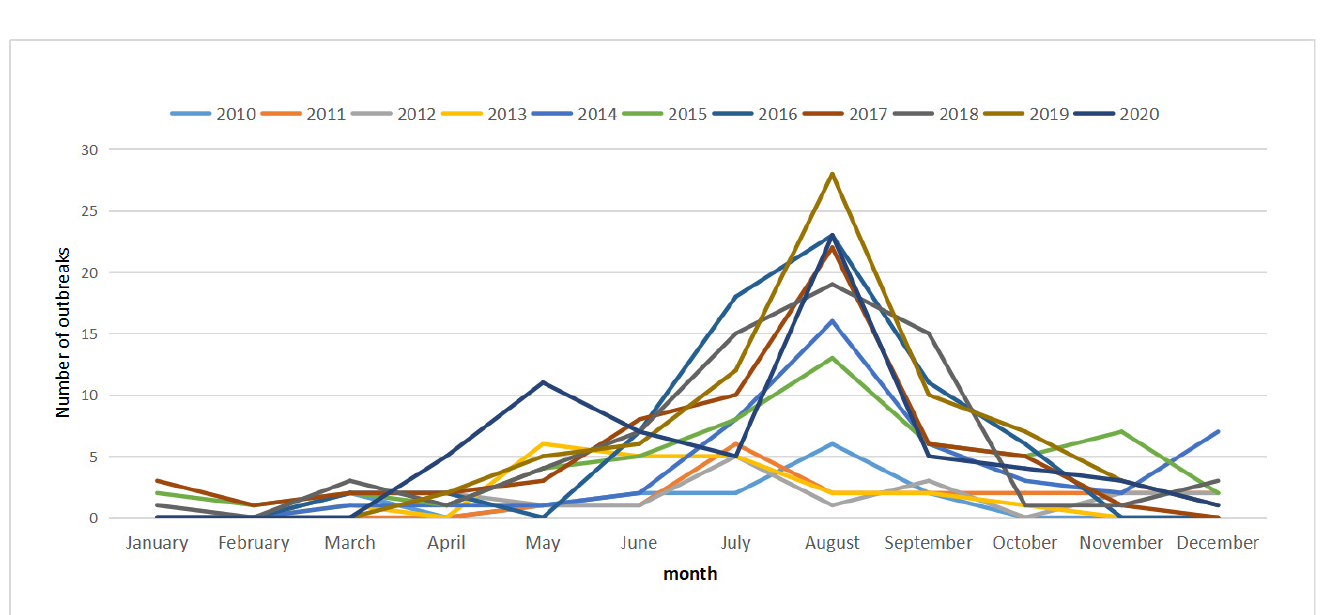
Figure 1. Year-month distribution of outbreaks of bacterial FBDOs in Zhejiang Province, 2010–2020.